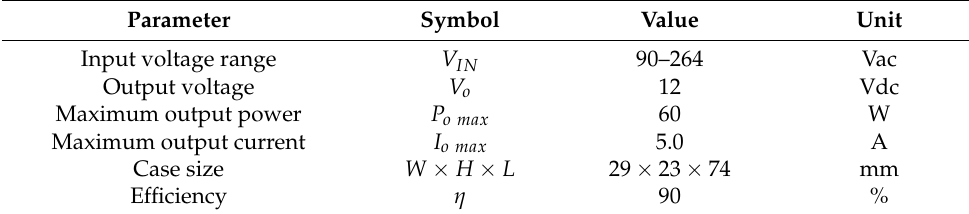
Table 1. Design conditions for QR flyback converter with